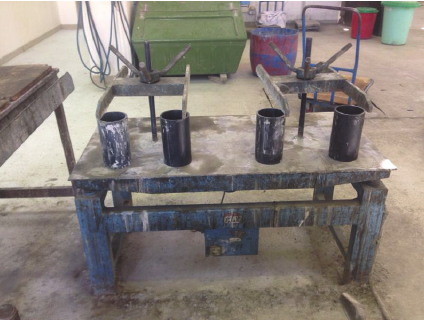
Table 4: Test results of CFRP confined specimens.